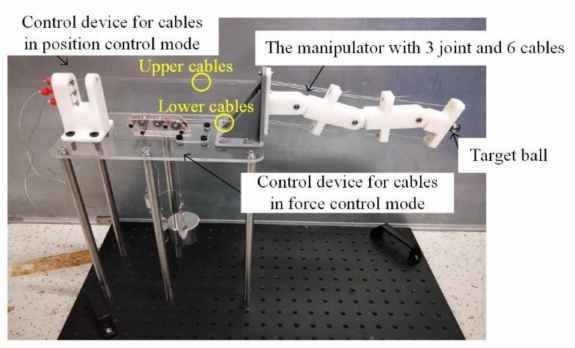
Figure 8. Experimental prototype and overall layout.